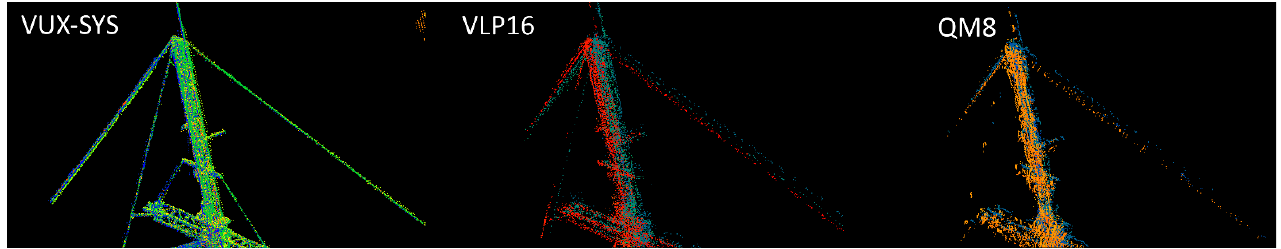
Figure 4. Cross sections of a 5 m slice show the differences in point density and point distribution. This is especially visible by the greater detail in the understory for the VUX-SYS. The flux tower was established after the ALS data acquisition, and was therefore lacking in the upper slice. The area shown covers a 200 m slice in the X direction, and 5 m in the Y direction. Values on the X axis are X-coordinates; values on the Y axis are heights given in UTM Zone 52S.